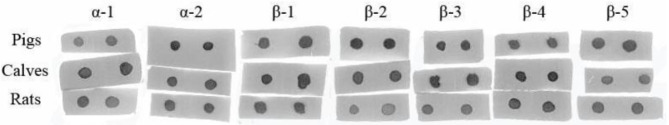
Comparison of the binding abilities of epitopes to the different animal species' allergic sera by dot-blot.